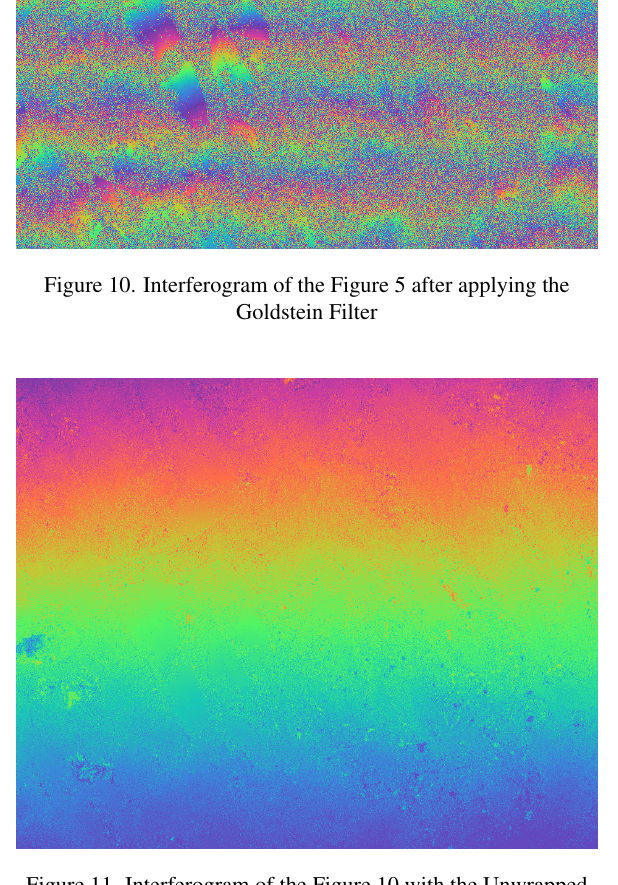
Figure 11. Interferogram of the Figure 10 with the Unwrapped